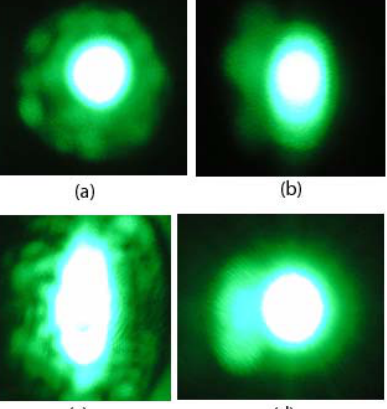
Table 1. Optical Damage Resistance of LN:Mg, LN:Hf, LN:Zr and LN:Sn. The data, except for the doping threshold, come from 6.5 mol% MgO, 4.0 mol% HfO